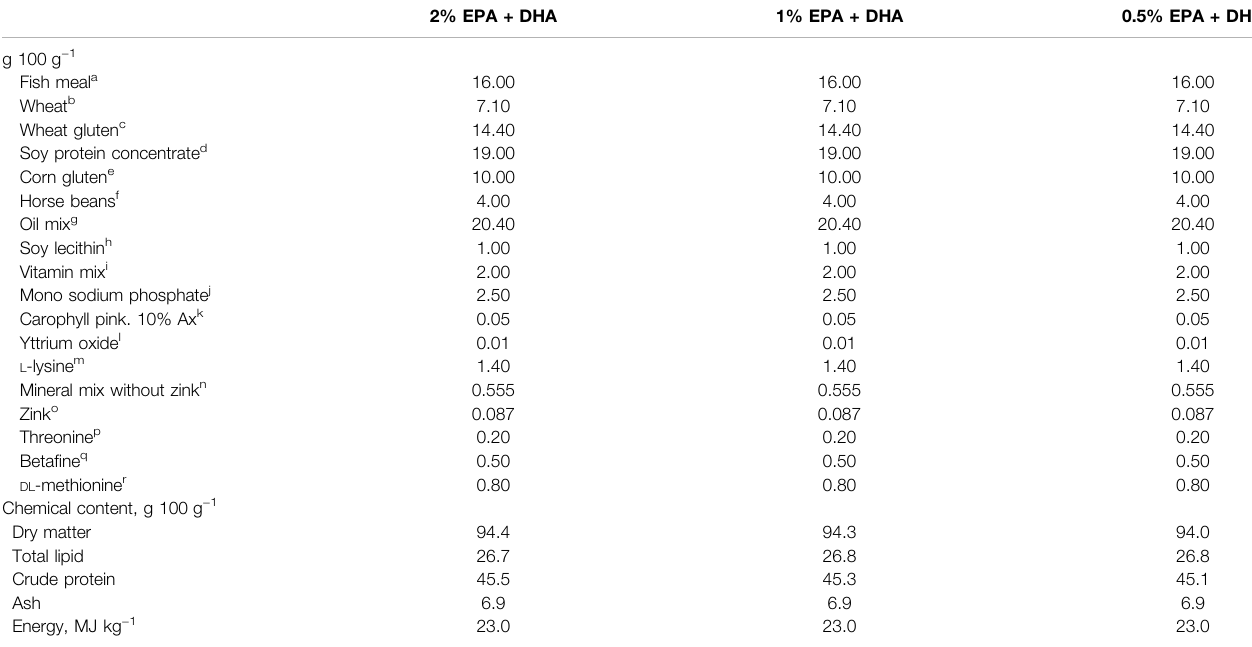
TABLE 1 | Composition of experimental